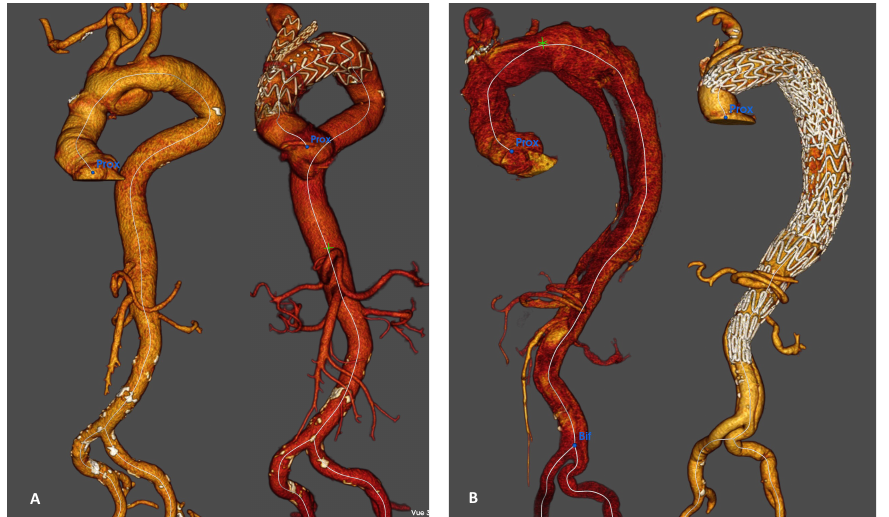
A B Figure 3. Branched endograft and hybrid repair for aneurysmal evolution of residual aortic dissection. ( A ): pre and post operative CT scan (volume rendering) after branched endograft for aneurysmal evolution limited to the aortic arch. ( B ): pre and post operative CT scan (volume rendering) after hybrid repair associated with TEVAR and STABILISE technique for a thoracic aneurysmal evolution.